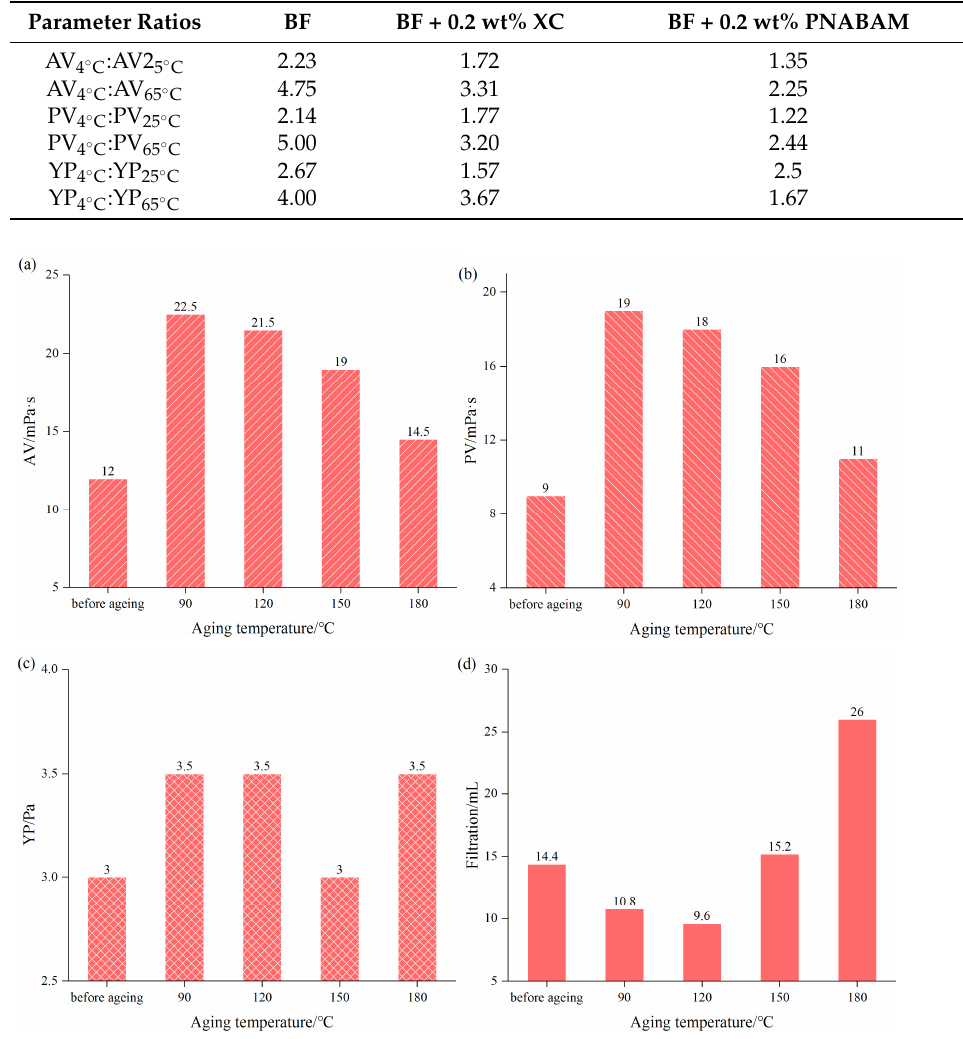
Figure 5. Effect of ageing temperature on the AV ( a ), PV ( b ), YP ( c ), and filtration ( d ) performance of PNBAM in BF. Table 2. General properties of drilling fluid